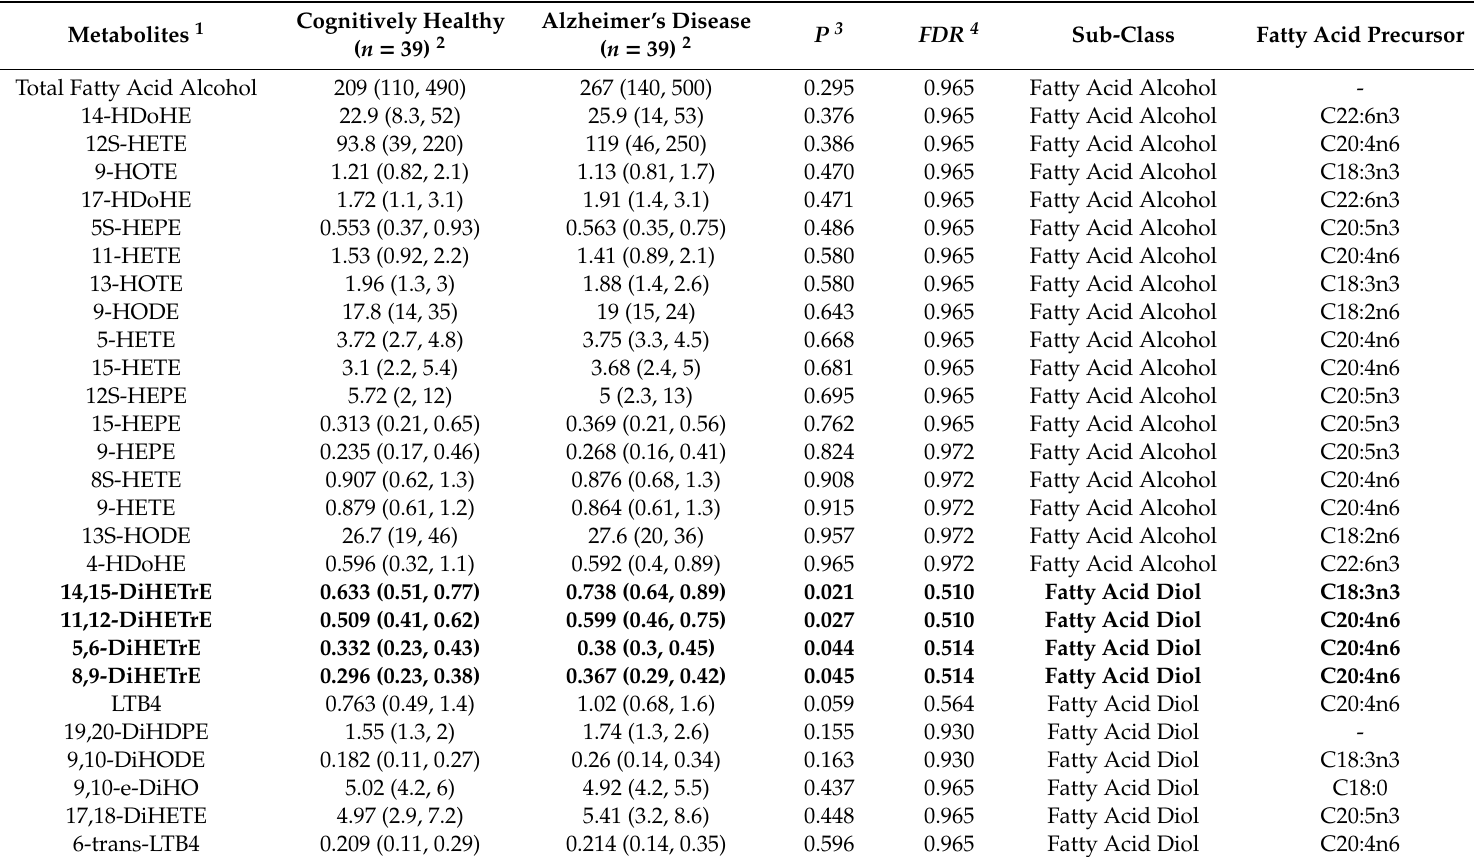
Table 1. Serum oxylipin concentrations and Alzheimer’s disease (AD) status in overnight-fasted nondiabetic elderly